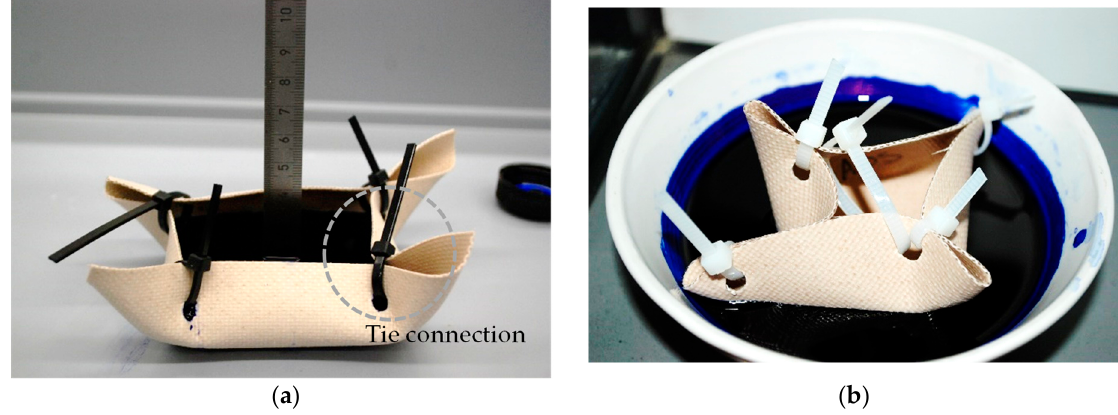
Figure 8. Out-of-plane ink penetration through coating thickness: ( a ) seepage in the direction of gravity and ( b ) seepage in the opposite direction of gravity.